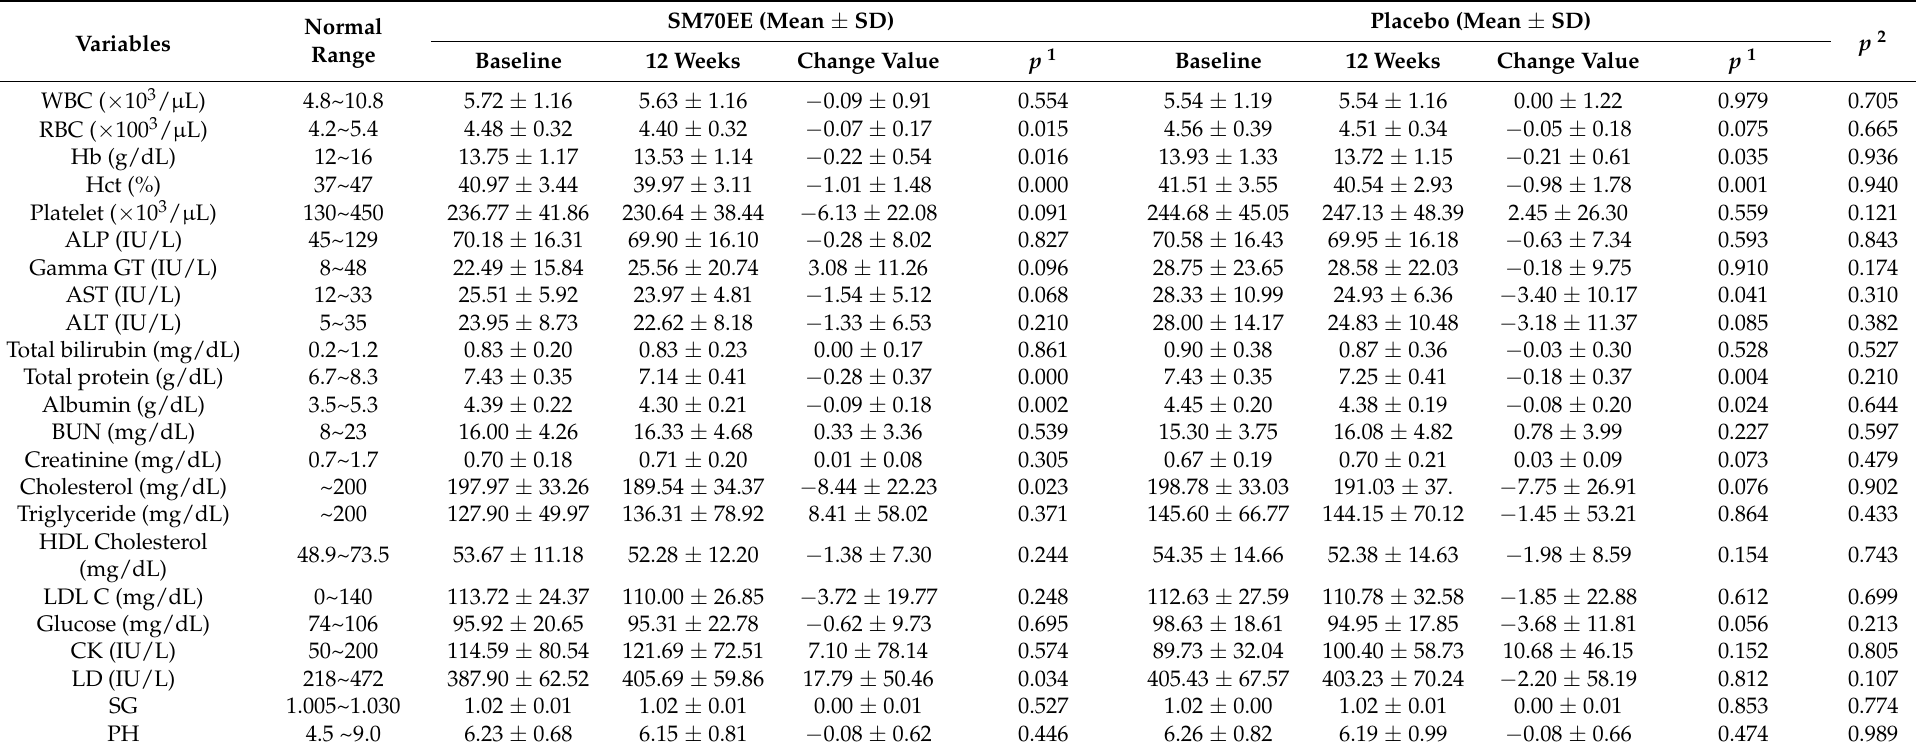
Table 7. Changes in the diagnostic medical test before and after 12 weeks of SM70EE product